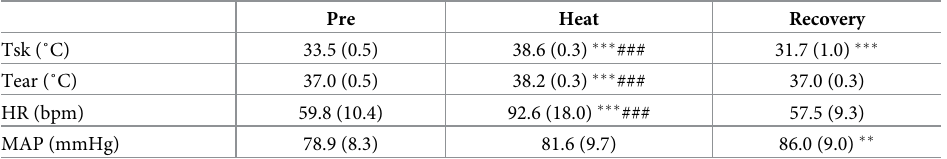
Table 1. Thermoregulatory and hemodynamic